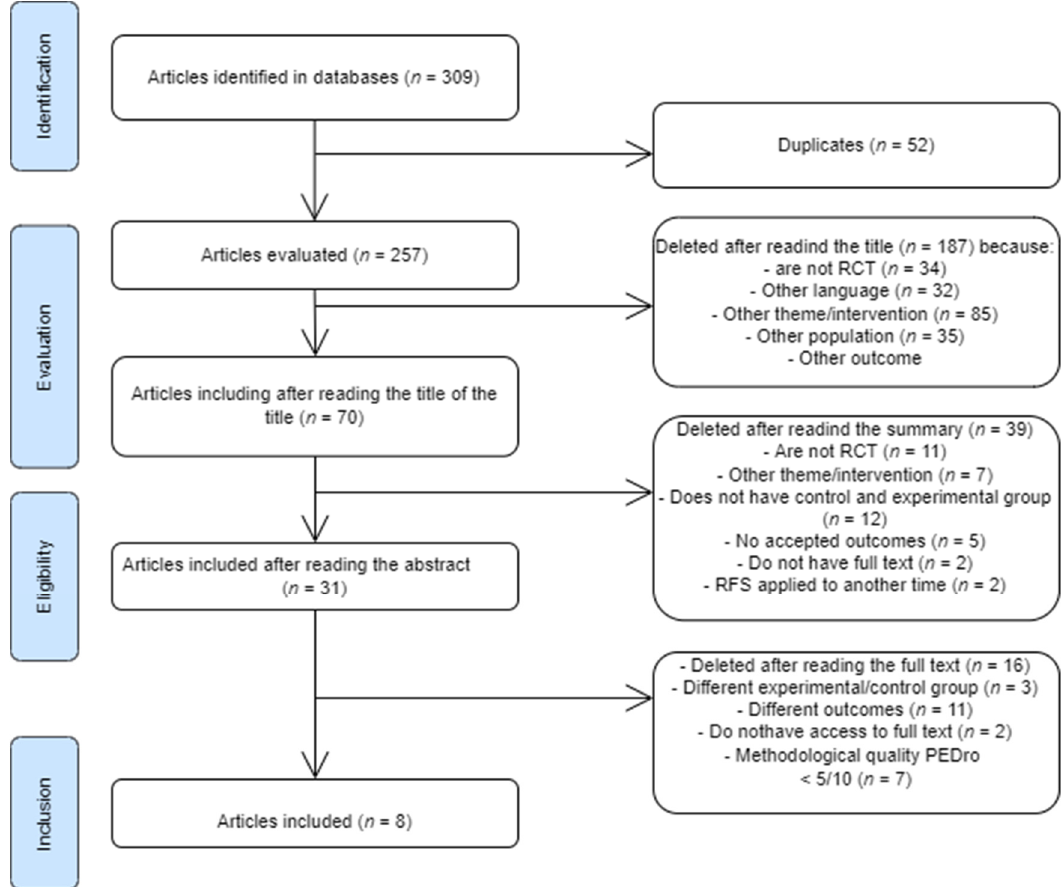
Figure 1. Prisma flowchart of included studies.